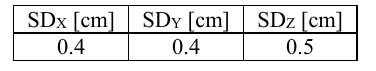
Table 4. Accuracy of points of adjusted